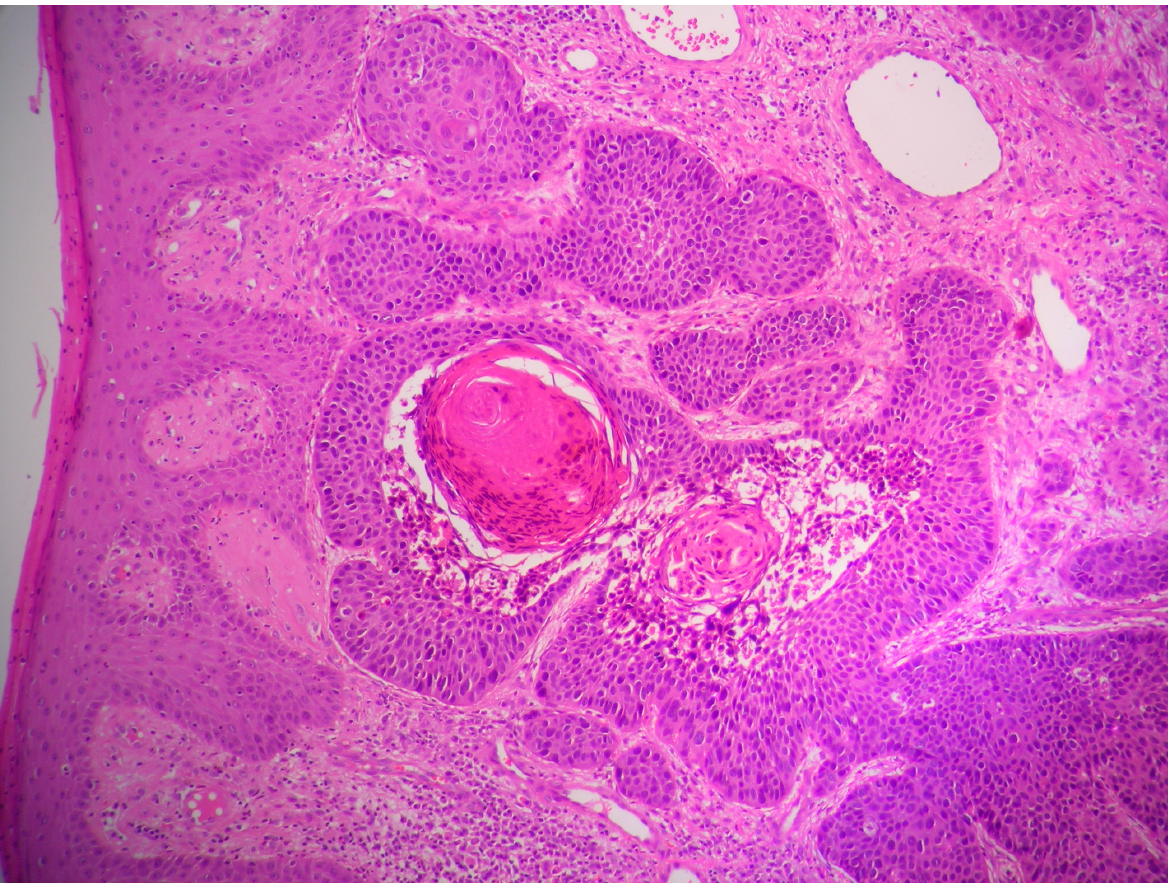
FIGURE 4. Pathology: In the dermis of penile mucosa, nests of neoplastic squamous cells with central keratinization (H&E, reduced from ×